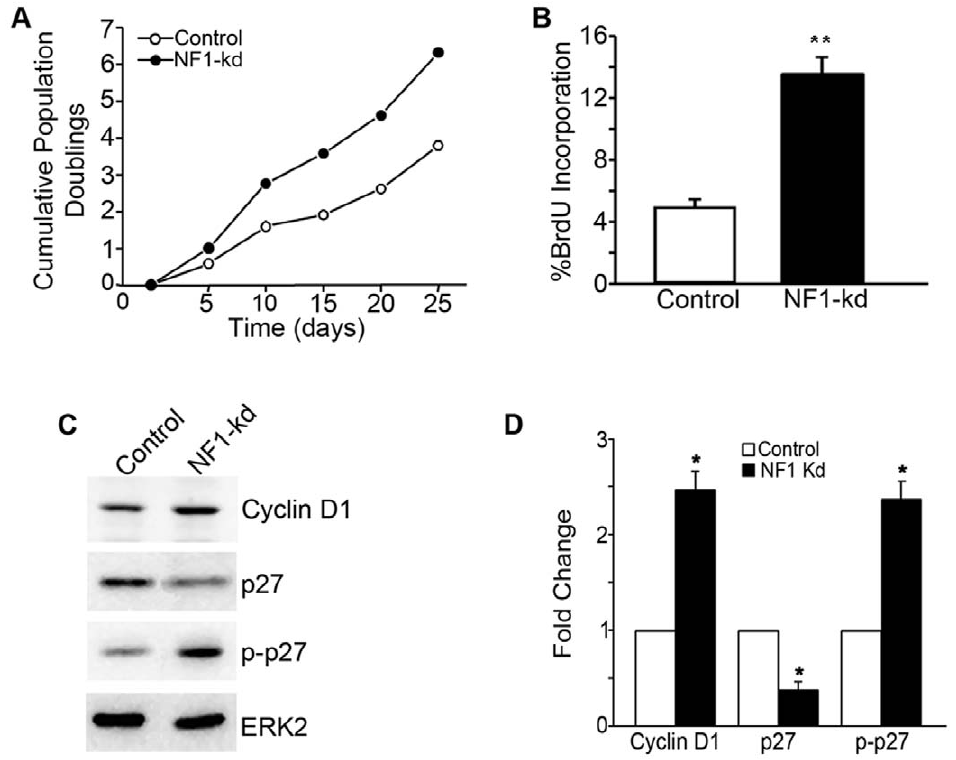
Figure 2. Loss of NF1 expression is sufficient to induce endothelial cell proliferation. (A) pSIREN Control and NF1 knockdown primary endothelial cells were grown in complete media under sub-confluent conditions and cumulative population doublings were recorded over the course of 25 days as described [10]. (B) Control or NF1 knockdown endothelial cells were serum deprived for 24 h prior to cells being pulsed with BrdU for 3 h. BrdU positive cells were quantified and the data was graphed as the % positive cells compared to total cell number. Data are presented as the mean with error bars representing the standard error (**p , 0.01). (C) In parallel to the experiments performed in (B), serum starved cell lysates were made after 24 h and probed with antibodies against cyclin D1, p27, phospho p27, and ERK2. ERK2 is used to insure equal loading of lysate. (D) In three independent experiments similar to those performed in (C), results were quantified and data expressed as fold-change from control. Error bars represent standard error of the mean (*p ,